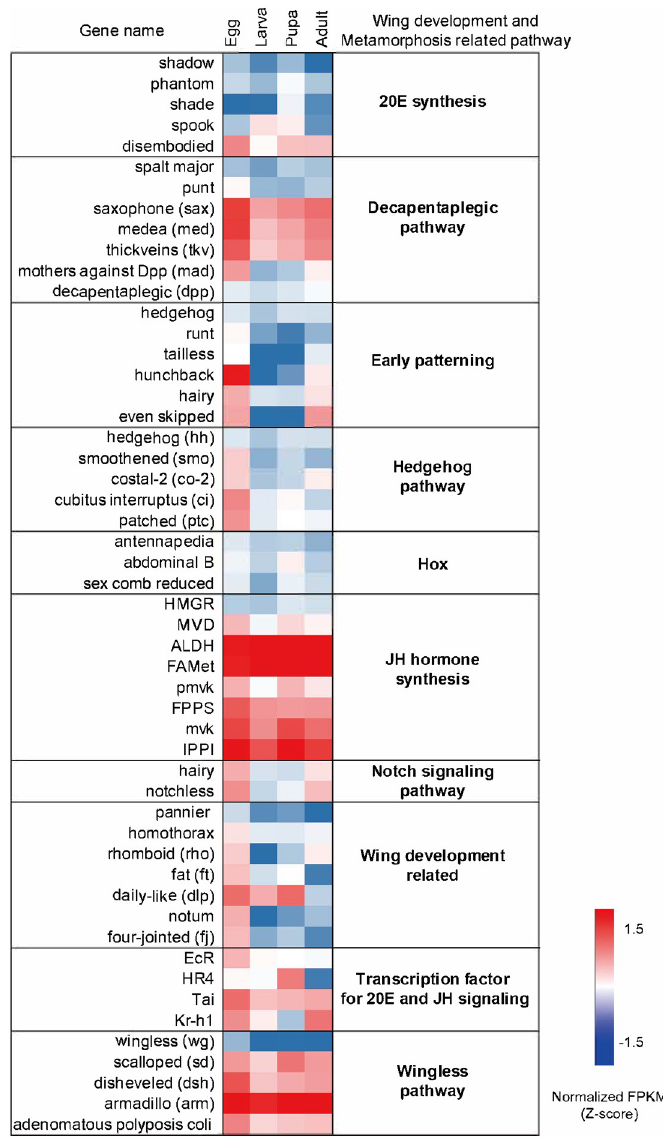
Fig 3. Comparison of P. b.seulensis transcriptome profiles of the genes related to development, early development, hox, and metamorphosis. The heatmap of gene expression profiles of 10 major wing development and metamorphosis functional categories. Each column stands for a developmental stage, for example, Egg, Larva, Pupa, and Adult, respectively, and each row represents a transcript. Red stands for high expression abundance, whereas blue represents low expression